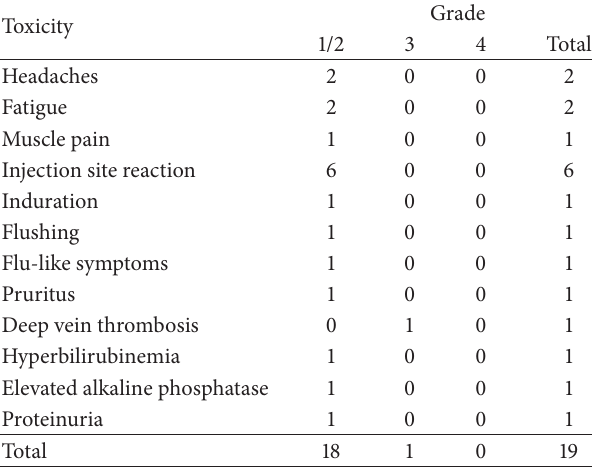
Table 2: Adverse events at least possibly related to